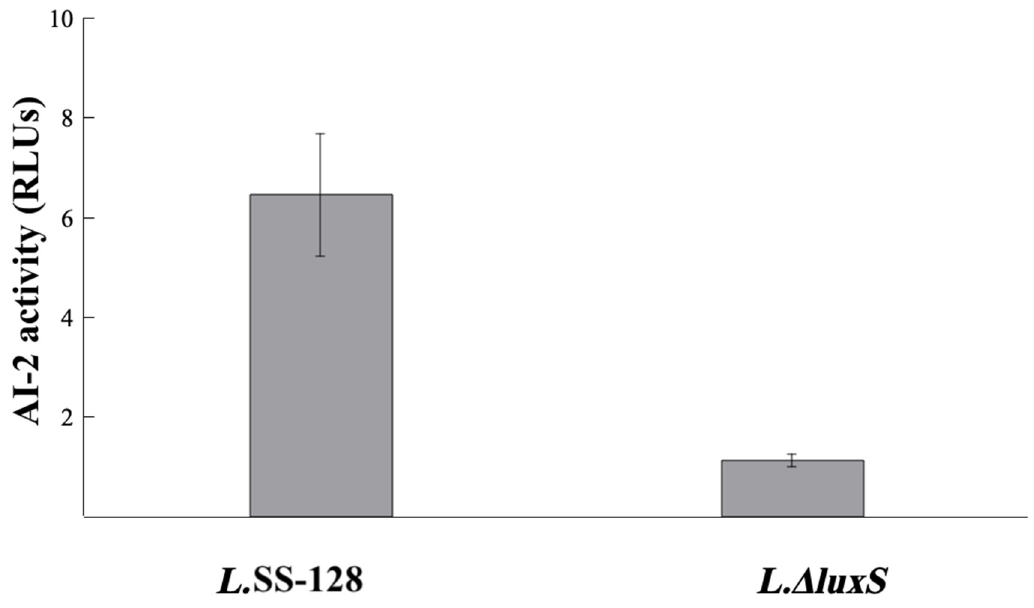
Figure 2. The AI-2 activity of L. SS-128 and L. Δ luxS.